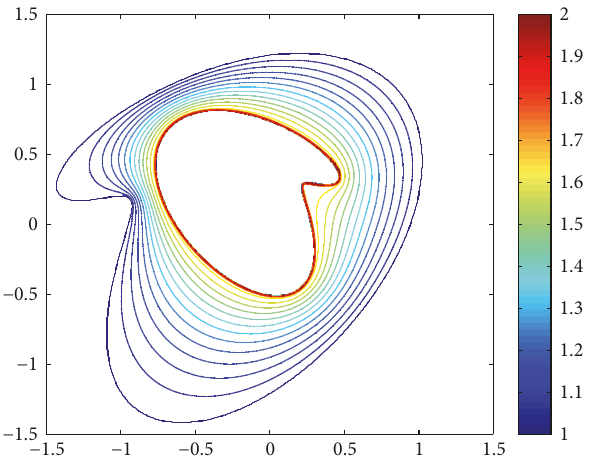
Figure 3: The absolute error along circle with radius max 𝑟 1 in Example